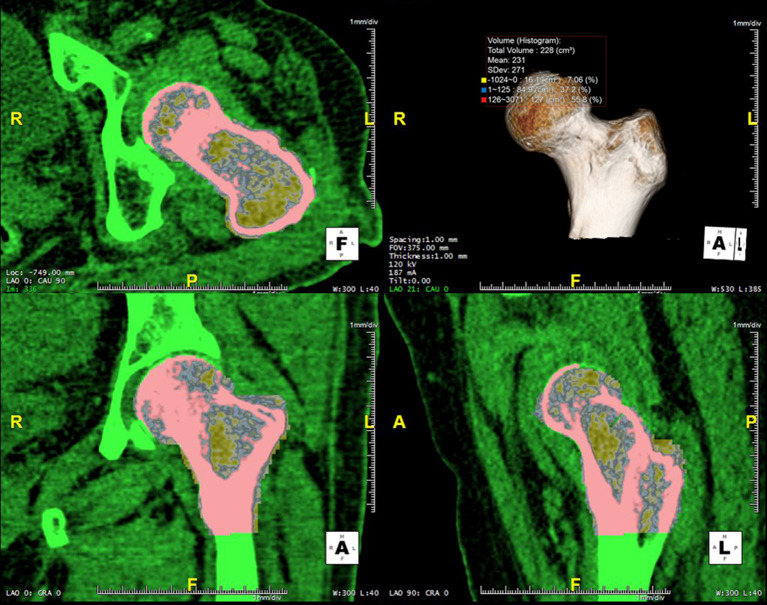
3D volume of interest (VOI) image analysis.3D multiplanar reconstructions and volume-rendered image analysis were performed using commercial 3D software (Aquarius iNtuition v4.4.12®). The femur was selected on the volume-rendered image using the regional growth method by checking all 2D multiplanar reconstructed images. The entire bone of the proximal femur from the femoral head to the inferior margin of the lesser trochanter was extracted and analyzed. The total volume (cm3), mean HU (HU), and HU histogram analysis (HUHA) were automatically calculated. Each HUHA is shown as both a volume (cm3) and as a percentage of the VOI (%). The HUHAfat (yellow box), which reflects the percentage of HU values of zero or less in the entire VOI, represents the fatty marrow. The HUHAdense-bone (red box), which reflects the percentage of HU values of 126 or above in the entire VOI, represents dense cortical bone.